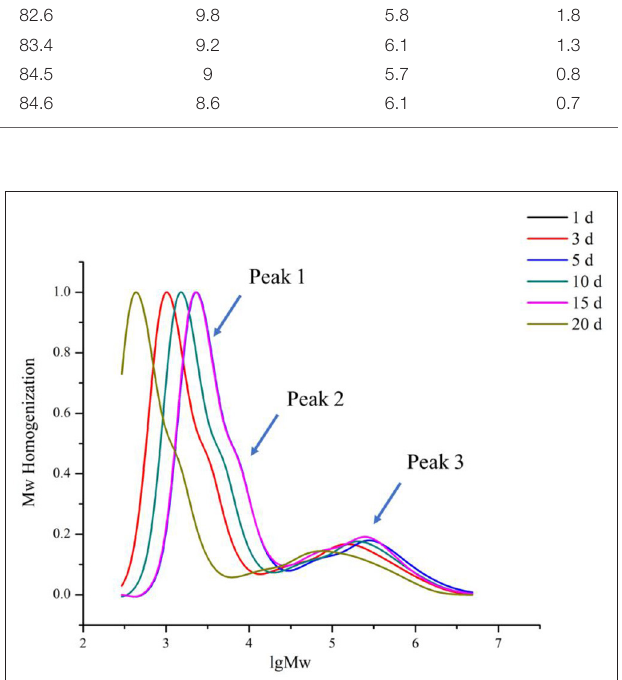
FIGURE 3 | Effect of natural fermentation on the chain length distribution of corn ballast